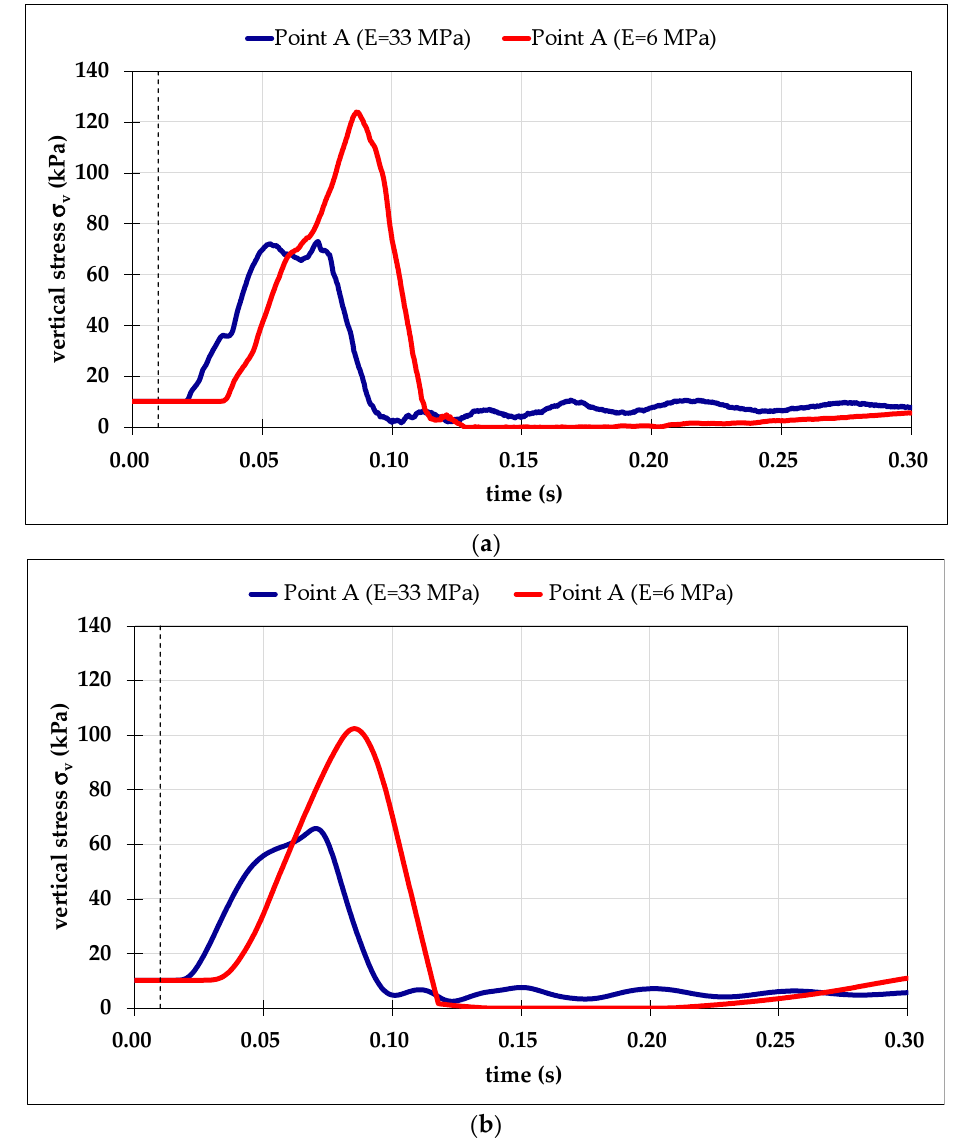
Figure 5. Vertical stress with time at a depth of about 4.5 m, along the loading vertical, for the two options of Young modulus, without ( a ) and with ( b ) damping. Collision time for this analysis: 0.1 s (maximum force: 360 kN). The vertical dashed line indicates the start of the impulse load. Table 3. The results of the FEM calculation for the three combinations of Young modulus and collision duration (or maximum